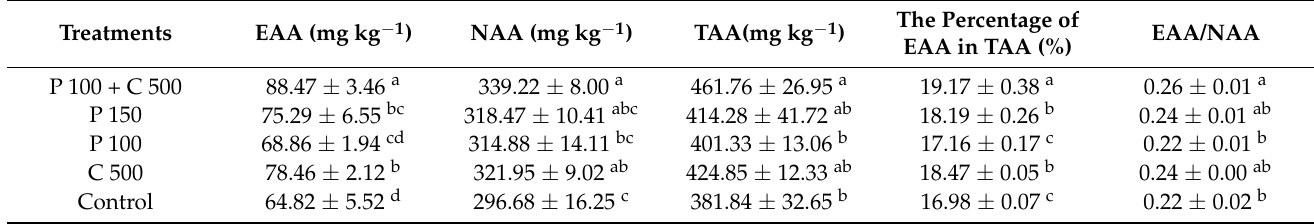
Table 4. The influence of pyraclostrobin and chitosan on R. roxburghii amino